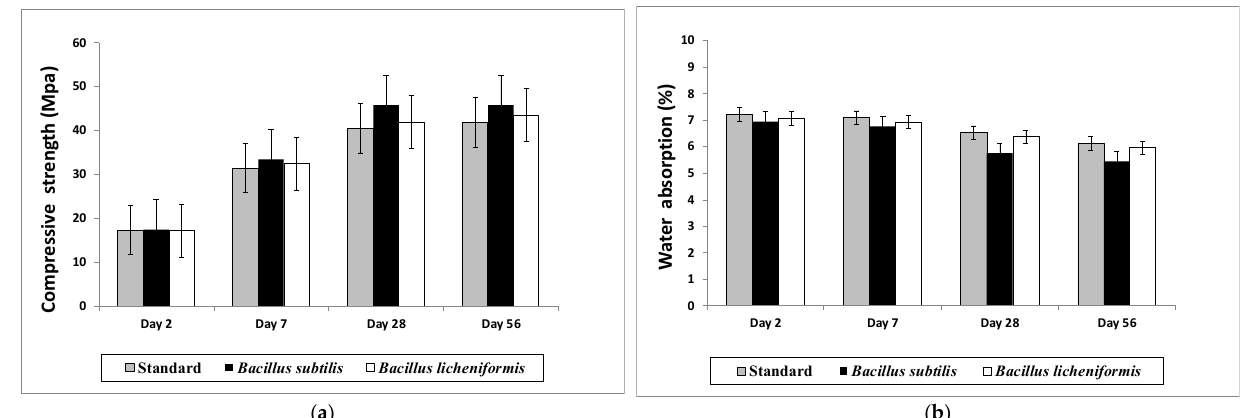
Figure 9. Compressive strength ( a ) and Water absorption ( b ) of mortar specimens after 2, 7, 28 and 56 days of curing.